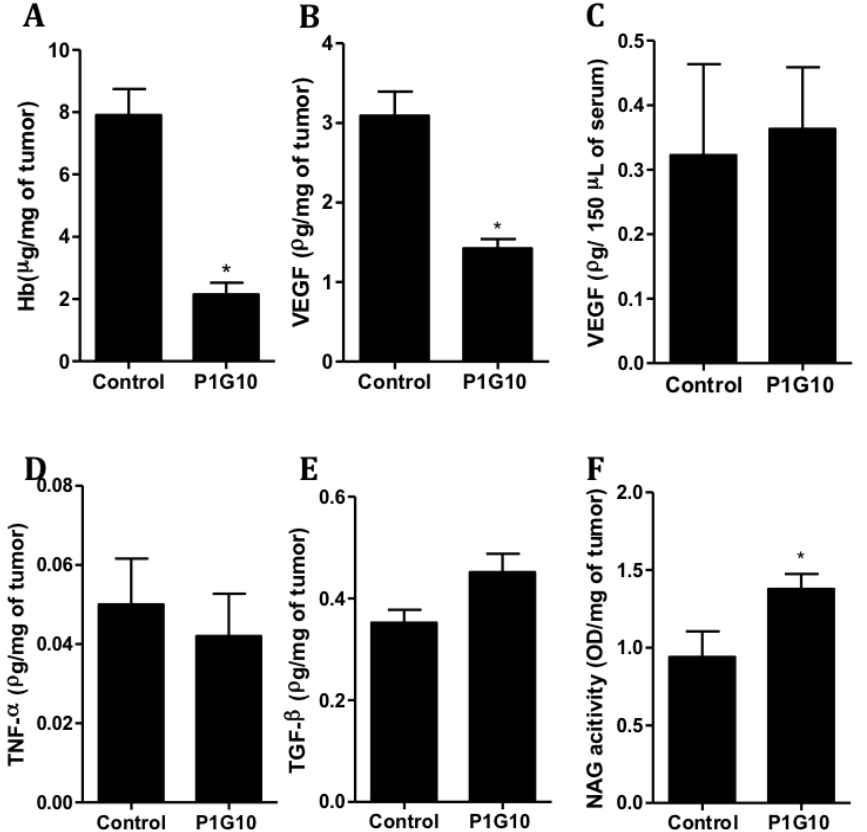
Figure 2. Angiogenic and inflammatory parameters in melanoma B16F1 animals treated with P1G10. Tumor tissue from animals ( n = 20) treated with P1G10 5 mg/kg or the control was processed and analyzed as described in Methods Section. Tumoral: ( A ) Hemoglobin (Hb); ( B ) Vascular endothelial growth factor (VEGF); ( D ) Tumor necrosis factor-α (TGF-α); ( E ) TGF-β; ( F ) N -acetyl-glucosaminidase (NAG) activity; Serum: ( C ) VEGF, * p < 0.01, Student’s t